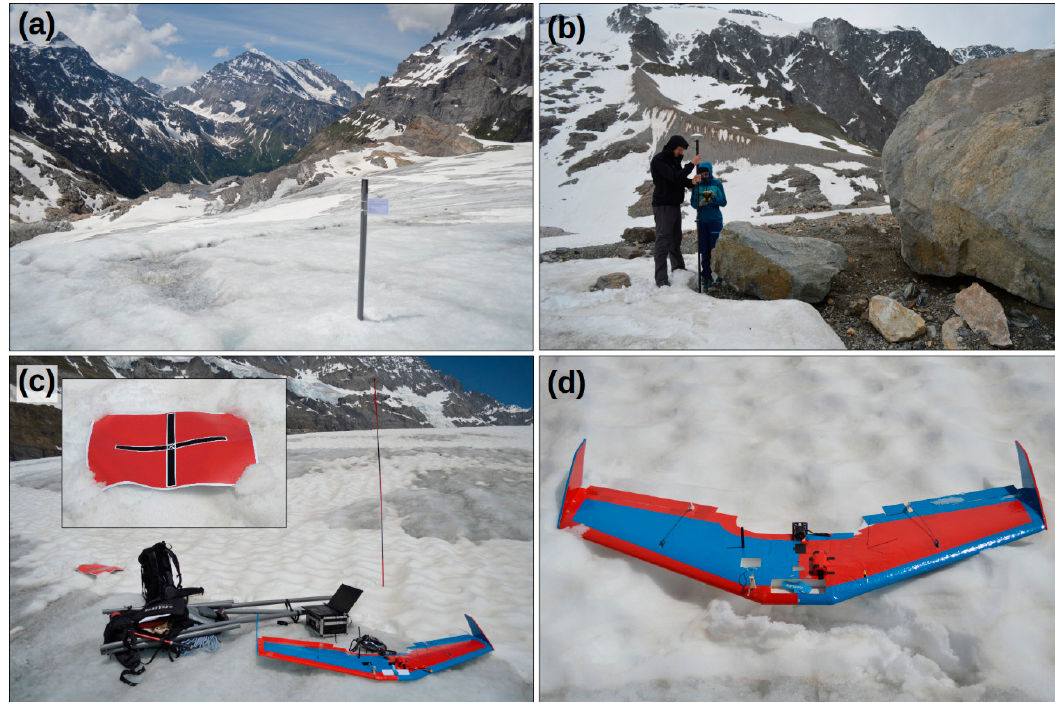
Figure 4. Fieldwork at the Kanderfirn. ( a ) Ablation stake (no. 10). ( b ) dGNSS measurement of a natural ground control points (GCP) in the glacier forefield. ( c ) Teflon marker (A2 paper size) and GCS computer. ( d ) Low-cost UAV.